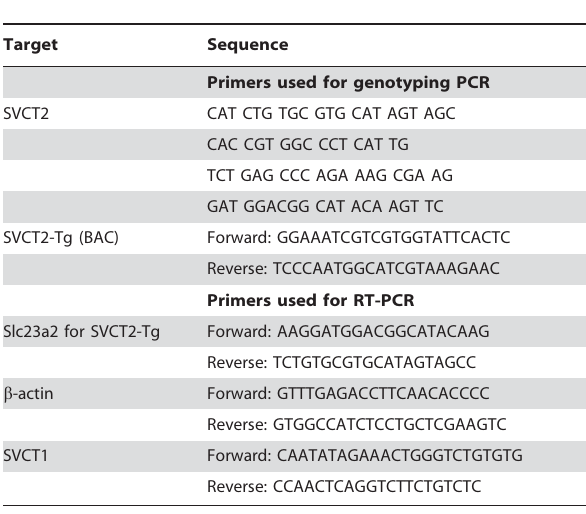
Table 1. Primer sequences used for